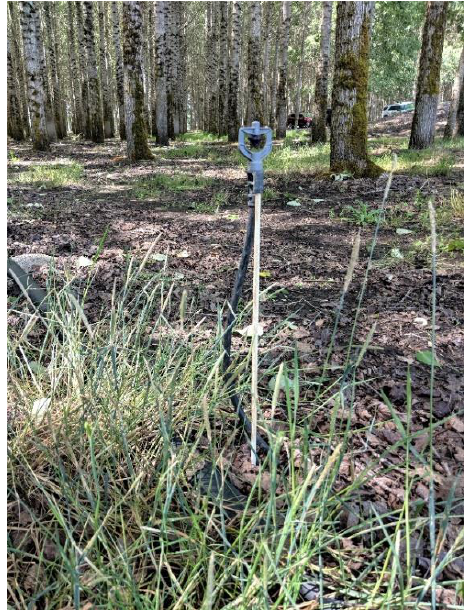
Figure 5. One of the 20,000 sprinkler heads used to irrigate the Chehalis Poplar Tree Plantation with reuse water.